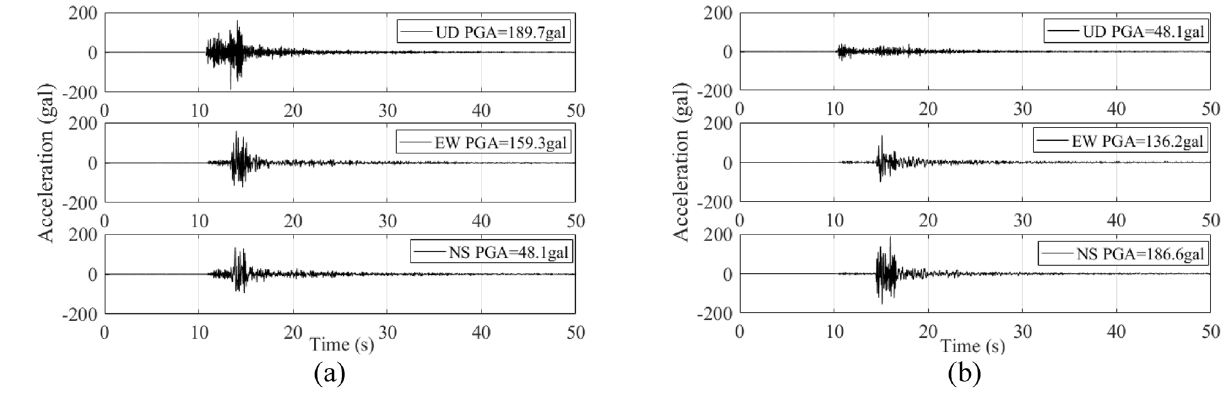
Figure 2. Strong motion record documented at ( a ) Daliba and ( b ) Fenghua